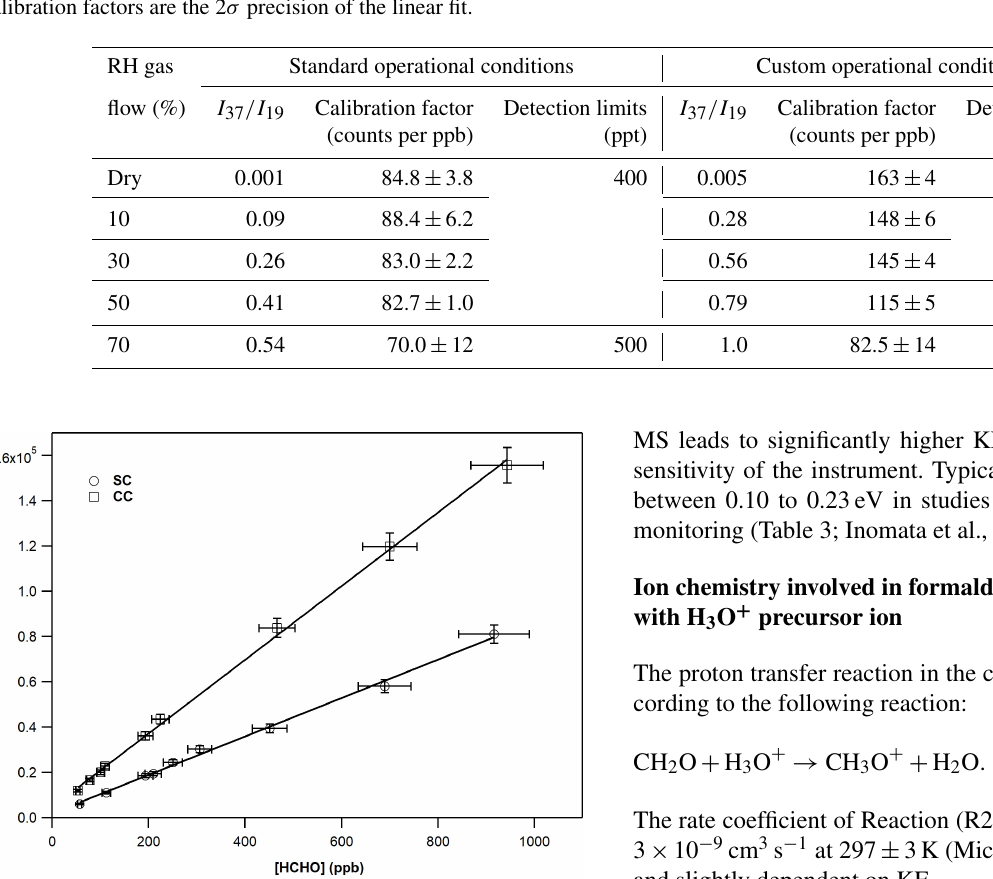
Table 2. Calibration factors and detection limits of FM at the m/z = 31 as a function of relative humidity for standard and custom operational conditions of the SIFT-MS. The calibration factor is derived from the slope of a typical experiment shown in Fig. 3. The errors given in the calibration factors are the 2 σ precision of the linear fit.